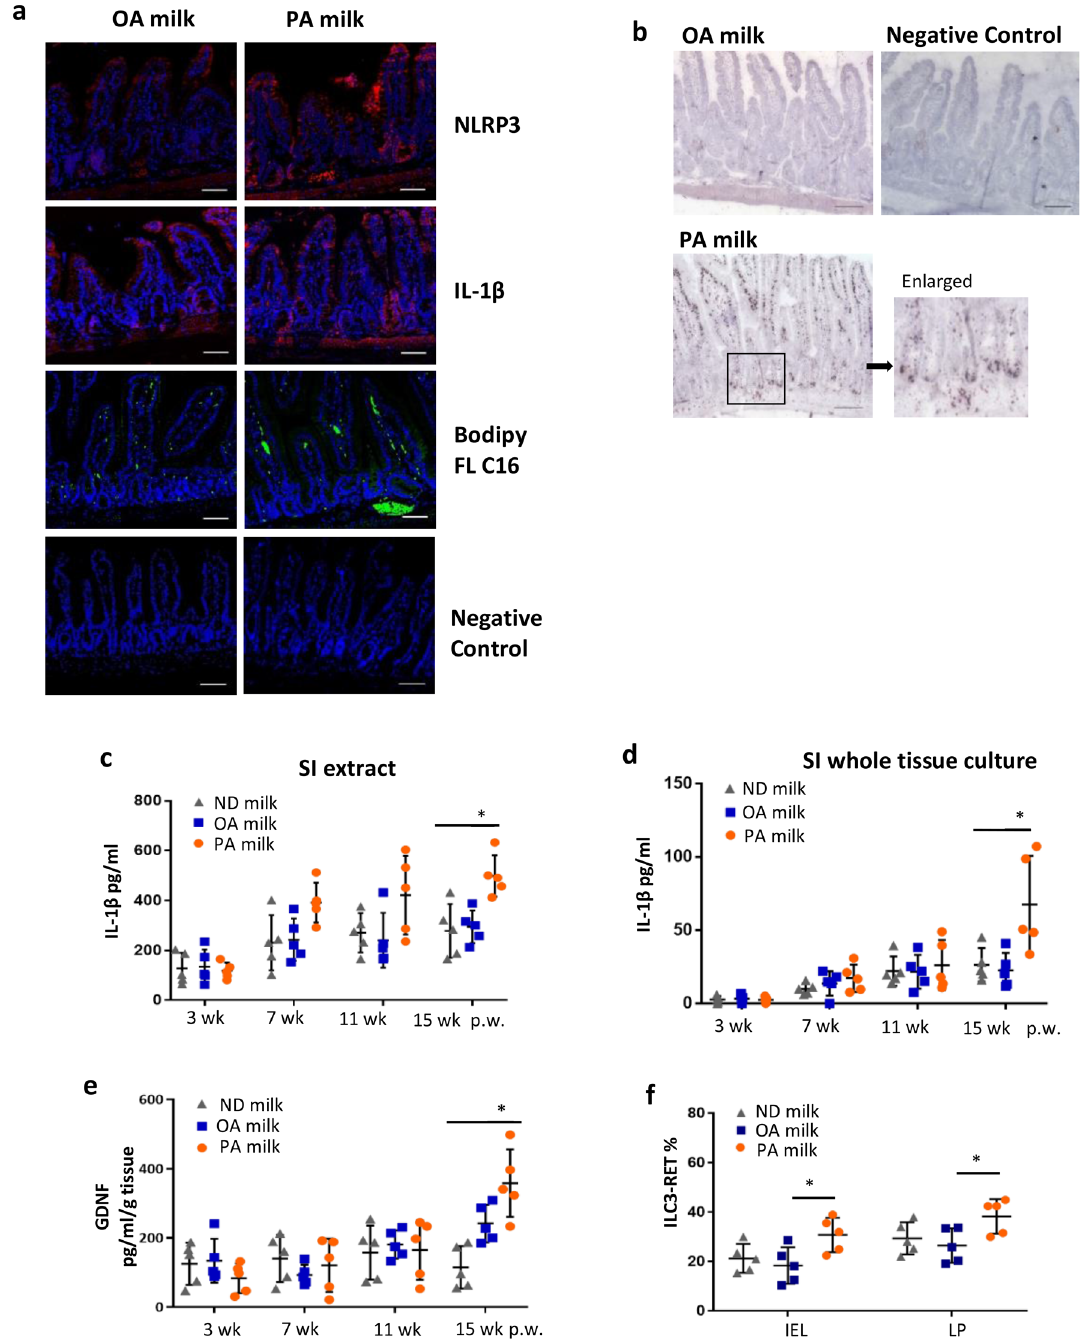
Figure 6. PA-milk diet induced inflammation in the gut and skin. ( a ) Representative immunofluorescence staining for NLRP3 (red), IL-1β (red) and Bodipy FL C16 (green) in the small intestine of mice at 15 weeks post-weaning (p.w.). Nuclei were stained with DAPI (blue). Scale bars, 100 µm. ( b ) Oil red O lipid staining of the small intestines of mice at 15 p.w. ELISA quantitation of IL-1β (pg/ml) in ( c ) small intestine (SI) extracts and ( d ) whole tissue culture taken from mice at indicated p.w. (n = 5 mice/group). SI extracts were obtained by lysis treatment and sonication. For whole tissue culture, small intestine was cut into small pieces and cultured on 24-well tissue dish for 18 h before the collection of supernatant for IL-1β quantitation. ( e ) ELISA quantitation of GDNF in small intestine extracts at indicated p.w. ( f ) Percentages of ILC3-RET expression in IEL and LP of mice at 15 weeks p.w. (n = 8 mice/group). * P < 0.05, ** P < 0.01, one-way ANOVA. Data are analyzed with Prism8 (version 8.4.3, https:// www. graph pad. com/ scien tific- softw are/ prism), and ImageJ (version 1.53, https:// imagej. nih. gov/ ij/ index.